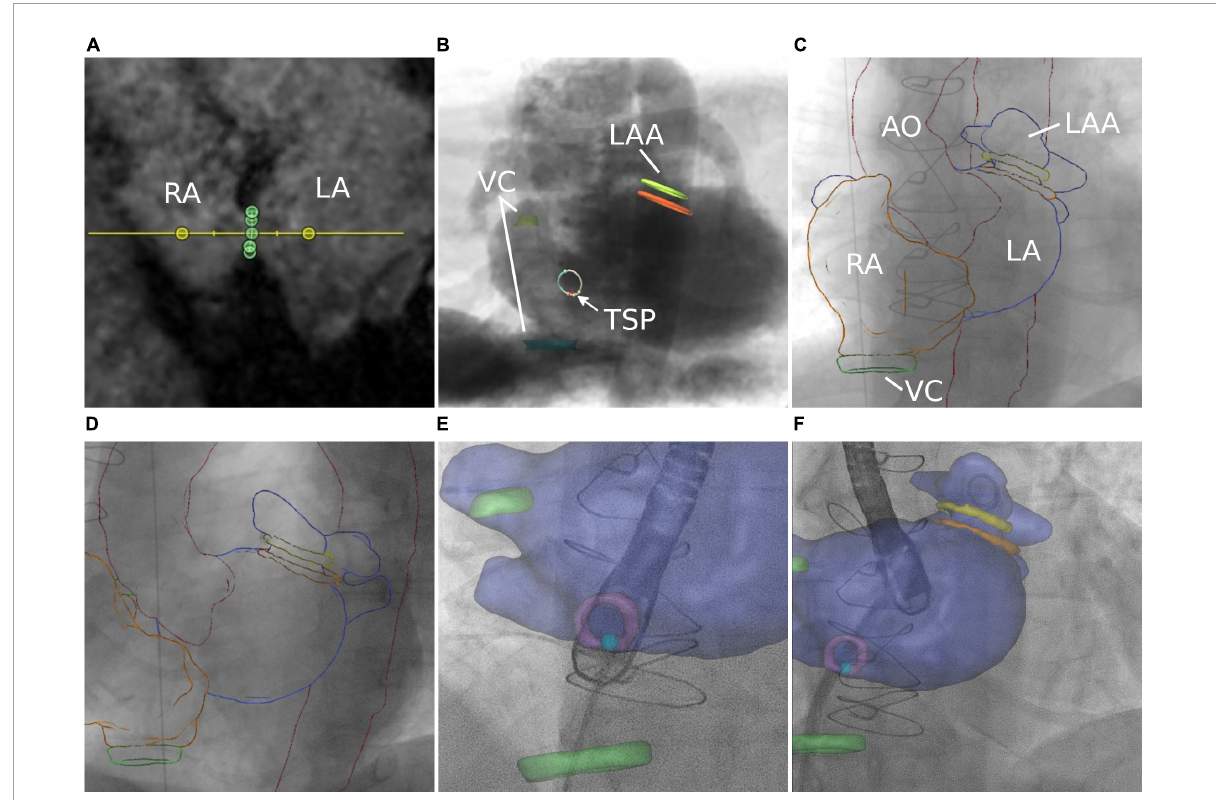
FIGURE5 Transseptal puncture. (A) MRI-based identification of the interatrial septum. (B) Simulation of posterior–anterior projection including MRI-based identification of left atrial appendage (LAA), septum, transseptal puncture (TSP), and vena cava (VC). (C,D) Manual registration is based on the aortic arch (AO) and right atrium (RA). Image fusion during TSP (E) and after successful access to the target structure (F)